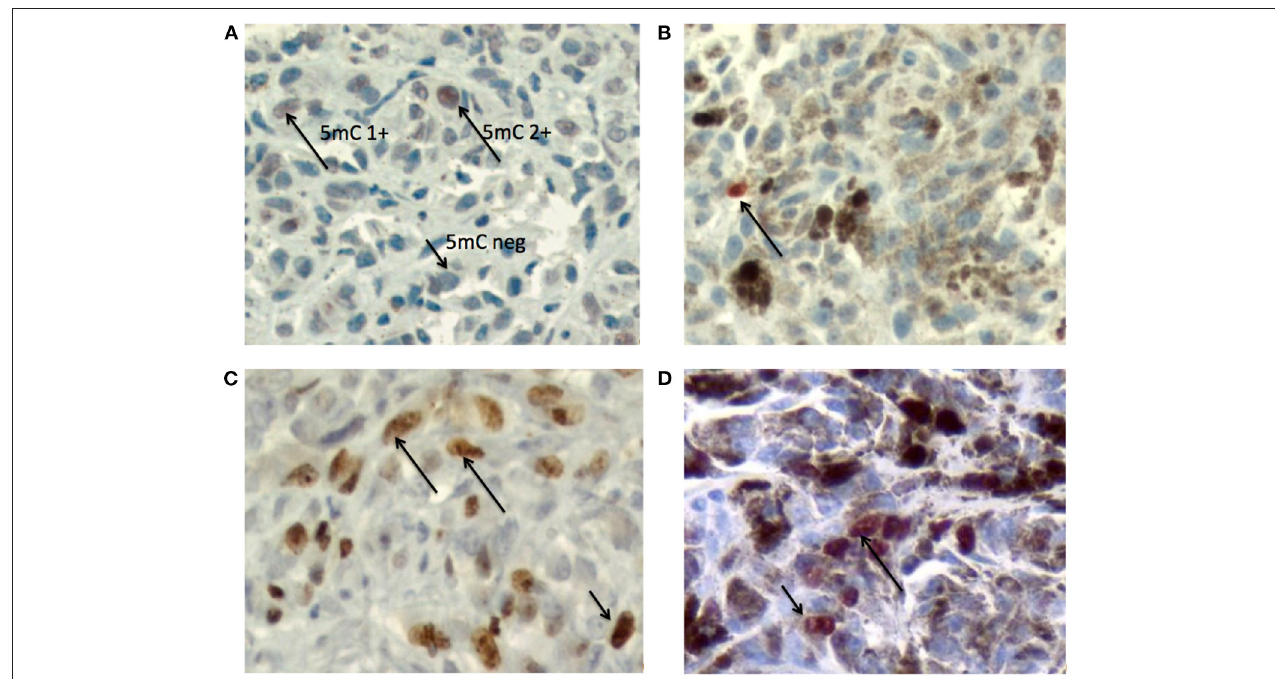
FIGURE 2 | Photomicrographs of the immunostainings for 5mC and Ki67 in melanotic and amelanotic OMM. (A) Immunostaining of 5mC in amelanotic OMM. Arrows indicate the patterns 5mC2 + and 5mC 1 + and 5mC 0 (DAB + hematoxylin). (B) Immunostaining of 5mC in melanotic OMM. Arrow indicates the 5mC 2 + nucleus (AEC + hematoxylin). (C) Immunostaining of Ki67 in amelanotic OMM. Arrows indicate a positive nuclei (DAB + hematoxylin). (D) Immunostaining of Ki67 in melanotic OMM. Arrows indicate positive nuclei (AEC + hematoxylin). Objective = 40x.